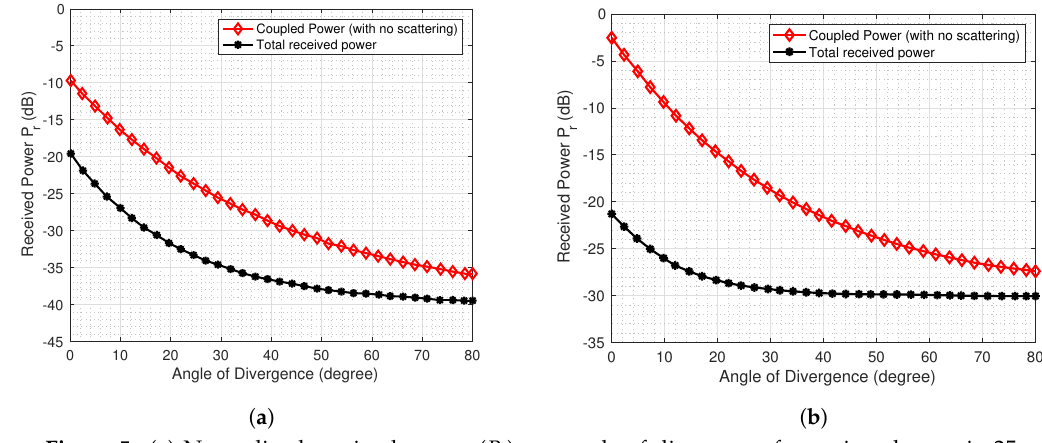
Figure 5. ( a ) Normalized received power ( P r ) vs. angle of divergence for various beams in 25 m clean water; ( b ) Normalized received power ( P r ) vs. angle of divergence for various beams in 10 m turbid